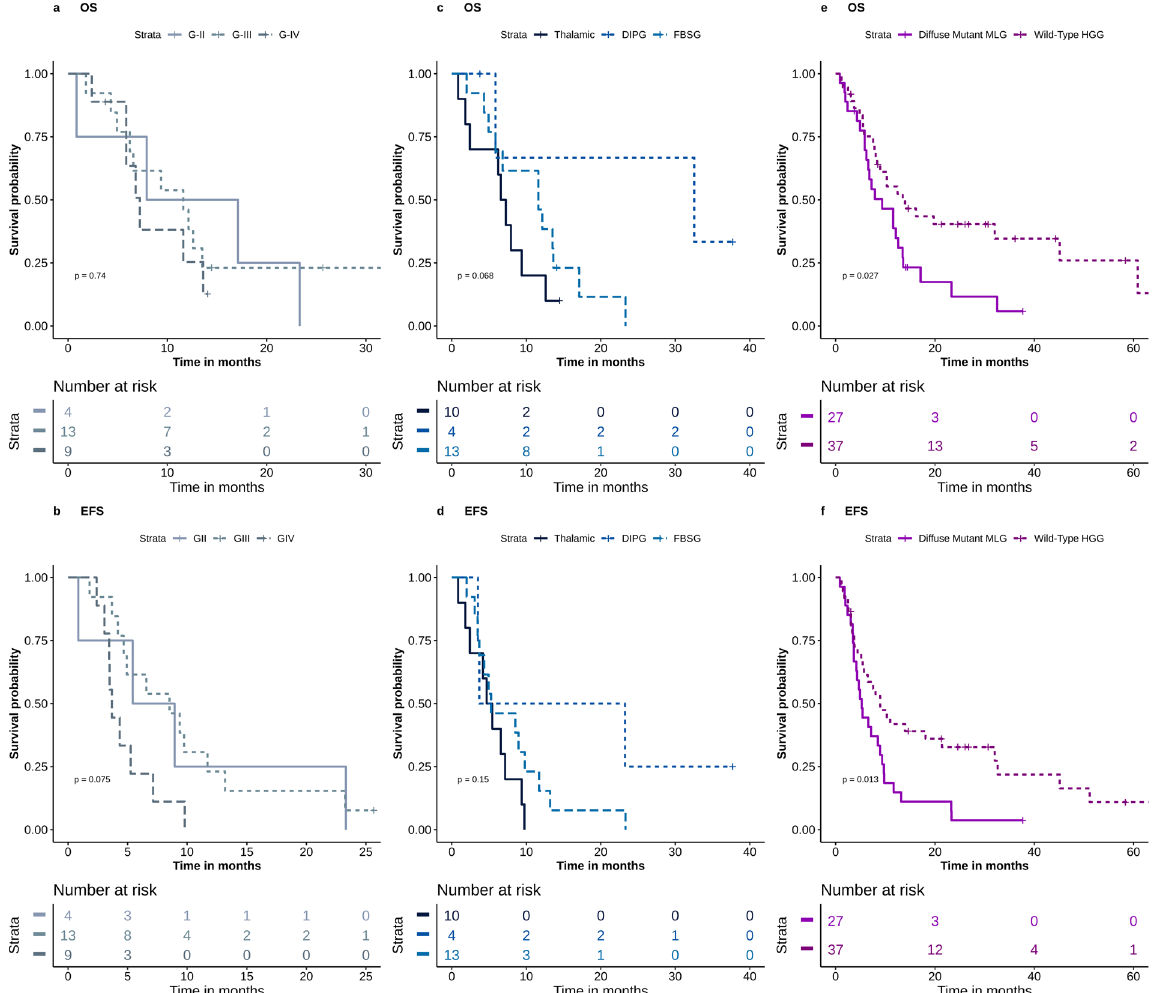
Figure 2. OS and EFS for different subgroups. ( a ) OS for mutant GII vs. GIII vs. GIV patients ( b ) EFS for mutant GII vs. GIII vs. GIV patients ( c ) OS for mutant FBSG vs. DIPG vs. thalamic gliomas ( d ) EFS for mutant FBSG vs. DIPG vs. thalamic gliomas ( e ) OS for diffuse mutant MLG vs. wild-type HGG ( f ) EFS for diffuse mutant MLG vs. wild-type